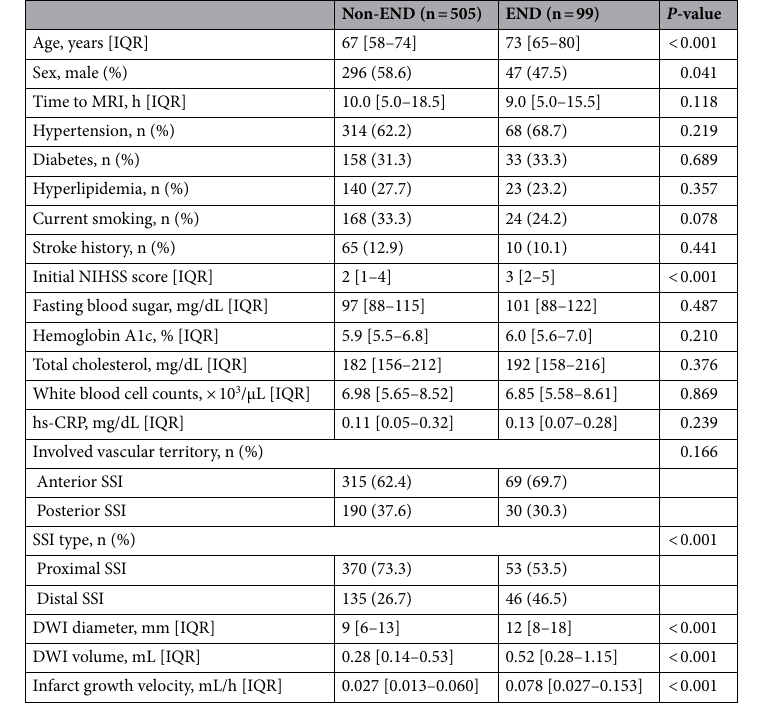
Table 2. Baseline characteristics of groups with and without early neurological deterioration. END early neurological deterioration, MRI magnetic resonance imaging, NIHSS National Institutes of Health Stroke Scale, hs-CRP high-sensitivity C-reactive protein, SSI single subcortical infarction, DWI diffusion-weighted imaging.